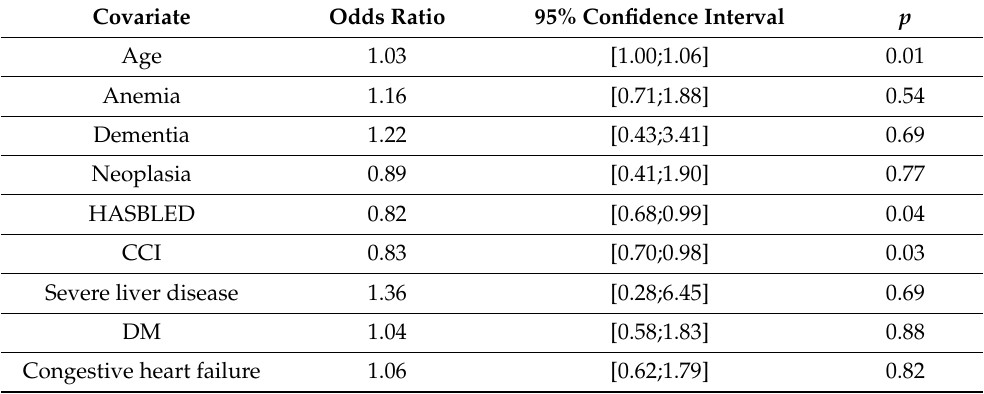
Table 5. Logistic regression model of predictors of decision to use NOAC versus AVK in group 2. Covariate Odds Ratio 95% Confidence